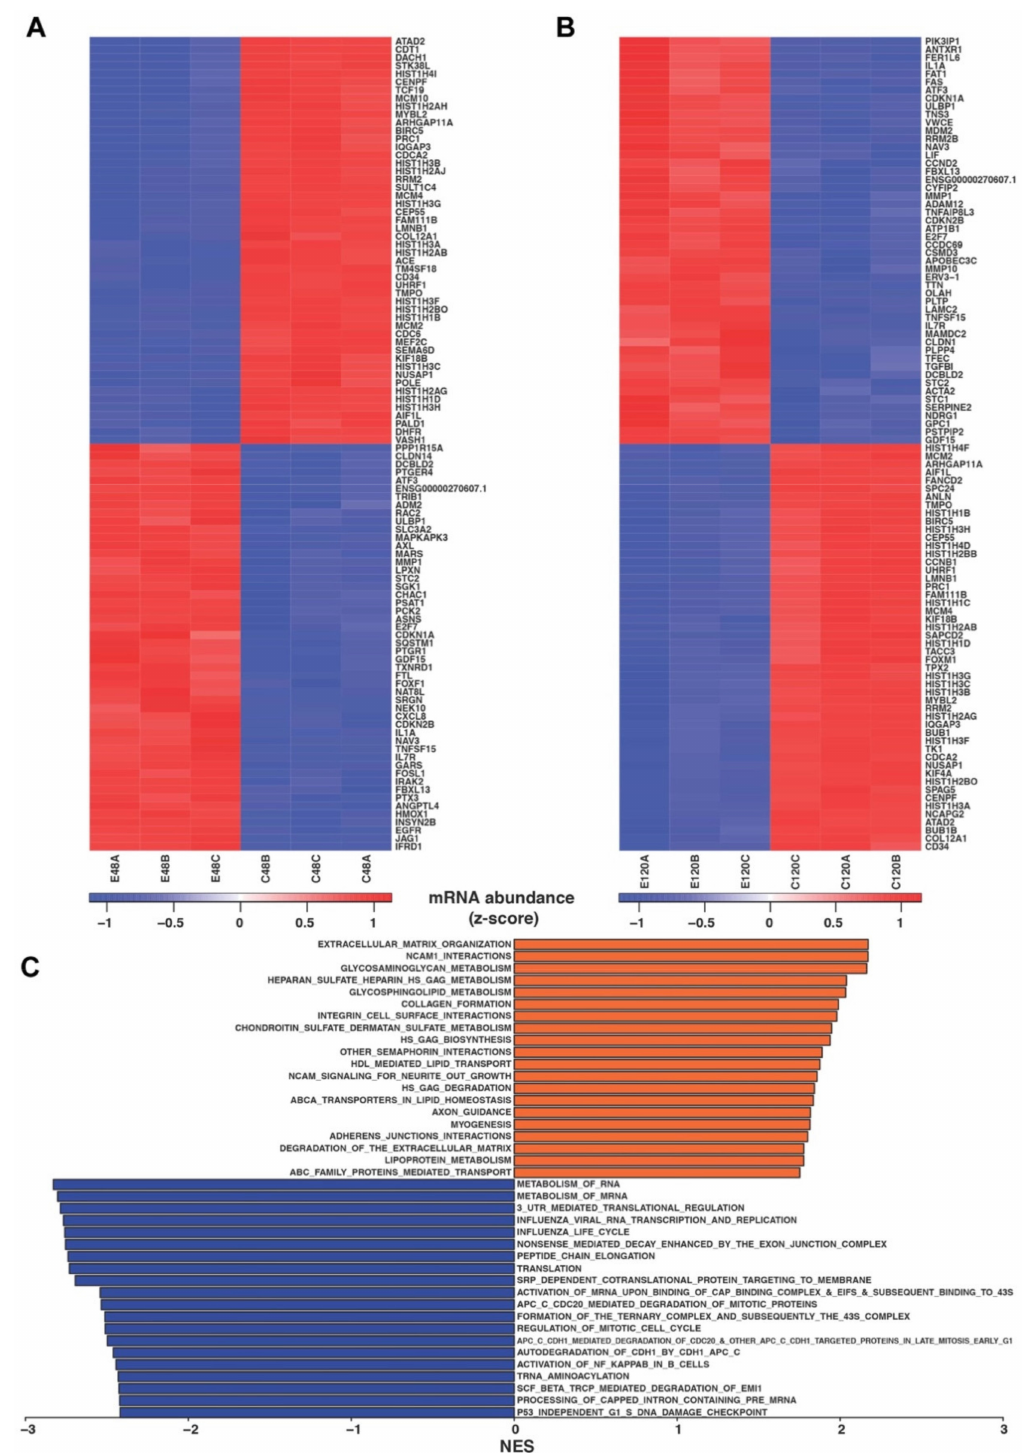
Figure 5. RNA-Seq analysis of coELTD1-expressing HUVECs. ( A ) Differential gene expression of top 50 upregulated genes and downregulated genes at 48 h (|log 2 FC| > 1 and FDR adjusted p value < 0.05). ( B ) Differential gene expression of top 50 upregulated genes and downregulated genes at 120 h (|log 2 FC| > 1 and FDR adjusted p value < 0.05). ( C ) Gene set enrichment analysis: Pre-ranked gene set enrichment analysis was performed using fgsea R package (v1.8.0) with REACTOME gene sets downloaded from MSig database [18]. Genes were ranked using: sgn (log 2 FC) × − log 10 P. For our analysis, we applied a minimum gene set size of 10 genes and performed the analysis using 500